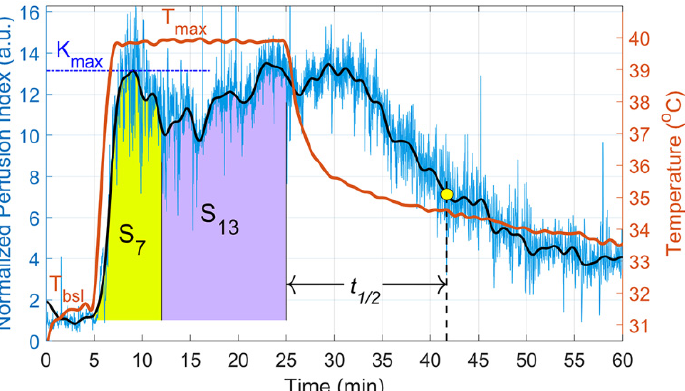
Figure 4. Dynamics of the normalized perfusion index for the same subject as in Figure 3. Blue curve shows unfiltered data, black curve—the same data after removing high-frequency noise, and red curve shows changes in the skin temperature.